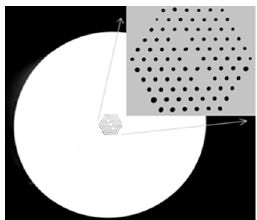
Figure 25. Cross-section of the PCF with three cores which is used for making intensity curvature sensor (Reproduced from [91], with the permission of IOP Elsevier publishing).